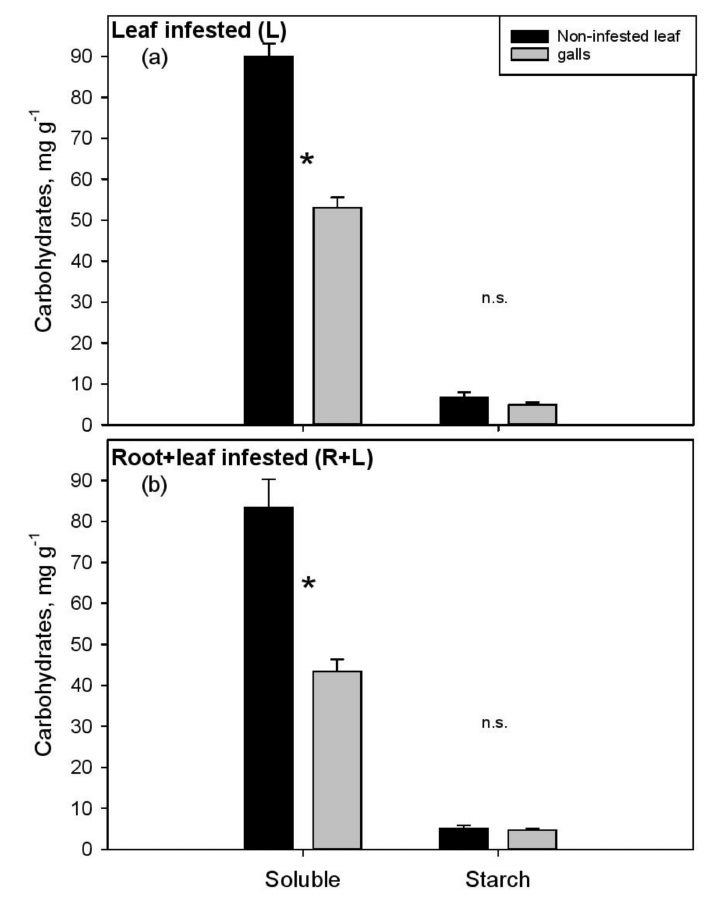
Figure 3. Soluble nonstructural carbohydrates and starch as measured in noninfested leaf portion (black bars) and in nearby galls (grey bars) sampled from leaf (L) ( a ) and both root and leaf infested (R + L) ( b ) plants 56 days after inoculation. * denotes significant difference between groups (Student’s t -test); n.s. indicates lack of significant differences.